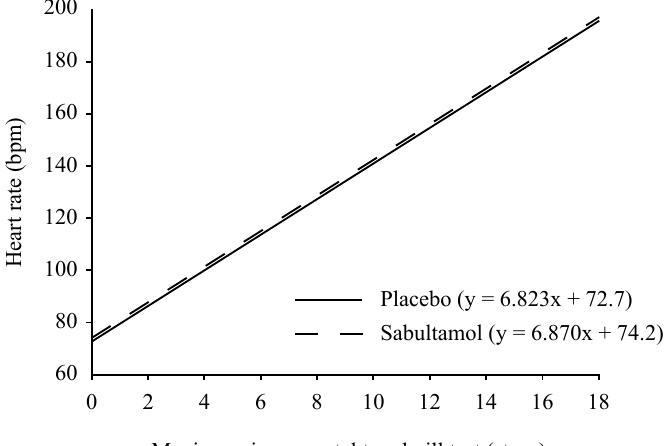
Figure 1. The mean value of the slope and the intercept obtained from the linear regressions of all individuals. Note the absence of differences between linear regressions (p > 0.05). Abbreviations: bpm = beats per